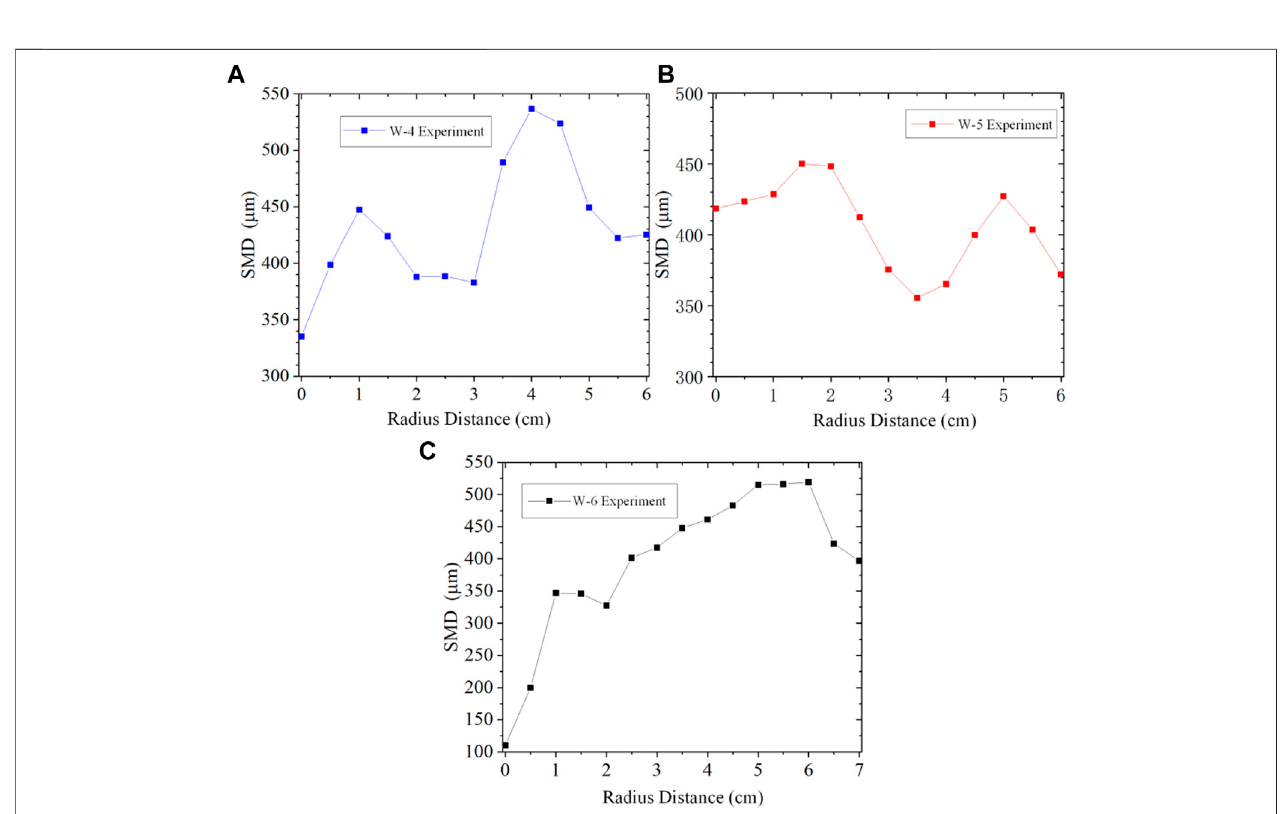
FIGURE 6 | The SMD distribution along the radius distance for the different coaxial injectors: (A) W-4 experiment, (B) W-5 experiment, and (C) W-6 experiment.